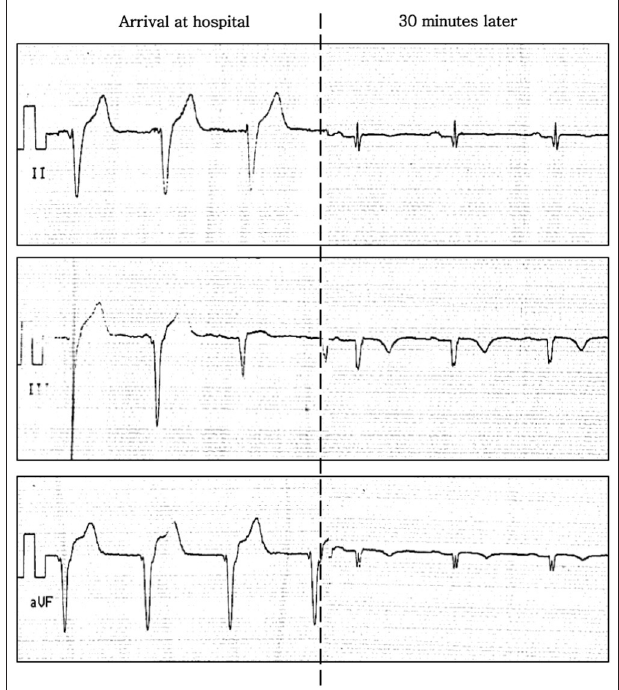
FIGURE 1 | ECG (inferior leads) on presentation to hospital whilst abroad. Left: arrival at hospital. Right: 30min later.